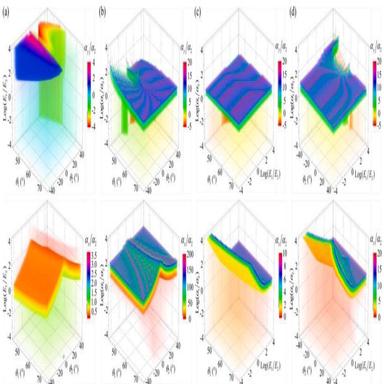
The influence of geometric parameters and constitute materials (relative stiffness E1/E2 and relative CTE α1/α2) on equivalent CTEs of composite 3D DVH lattices, αy/α2 and αx/α2 of composite 3D DVH lattices as functions of (a) θ1, θ2 and relative stiffness E1/E2 (α1/α2 = 0.1), (b) θ1, θ2 and relative CTE α1/α2 (E1/E2 = 100), (c) θ1, relative stiffness E1/E2, relative CTE α1/ α2 (θ2 = 30◦) and (d) θ2, relative stiffness E1/E2, relative CTE α1/α2 (θ1 = 60◦) with geometric constraints t1/l = t2/l = b/l = 0.1.